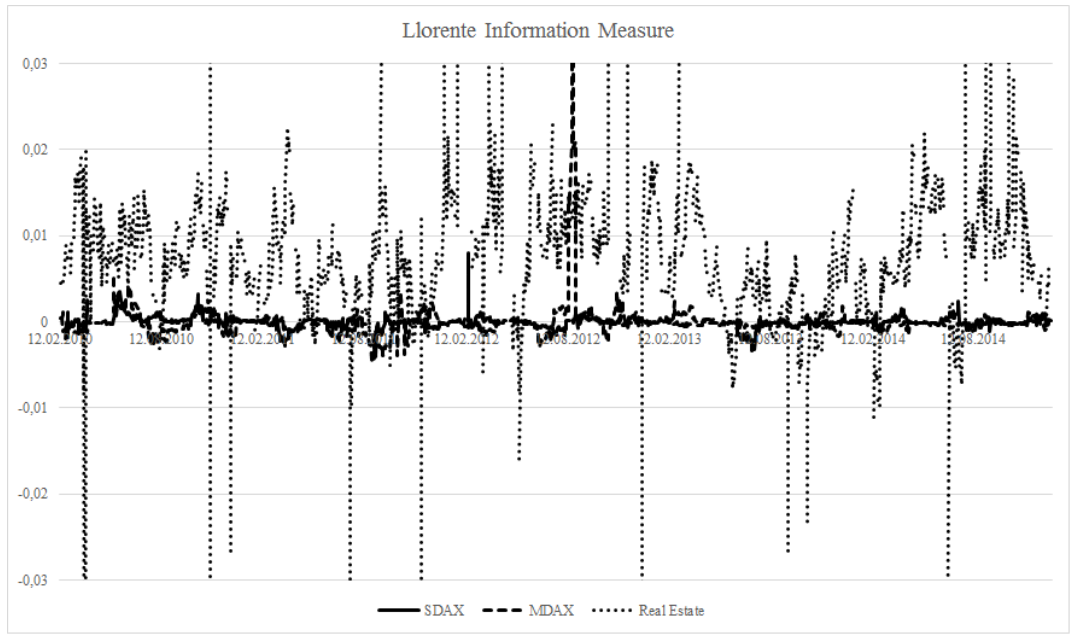
Figure 3. Estimates of rolling window Llorente information measures. The figure is a graphical representation of rolling window Llorente information measures averaged for the sub-samples of real estate stocks, as well as the constituents of the MDAX and the SDAX.